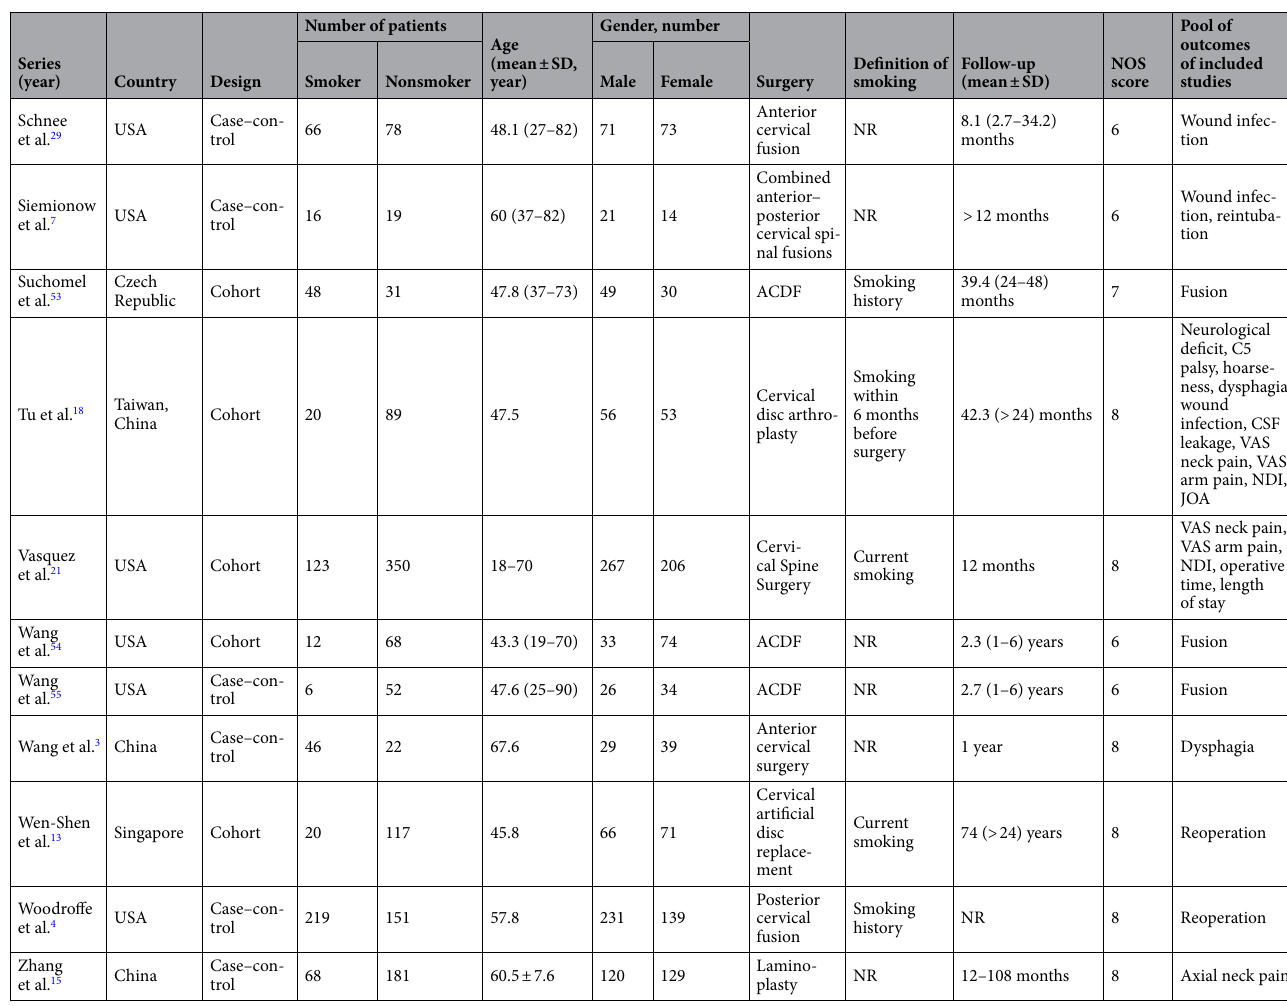
Table 1. Baseline characteristics of included studies. NR not reported, NOS Newcastle–Ottawa Scale, ACDF anterior cervical discectomy and fusion, SD standard deviation, NDI neck disability index, VAS visual analog scale, JOA Japanese Orthopaedic Association Scores for Assessment of Cervical Myelopathy, EBL estimated blood loss, CSF cerebrospinal fluid, DVT deep venous